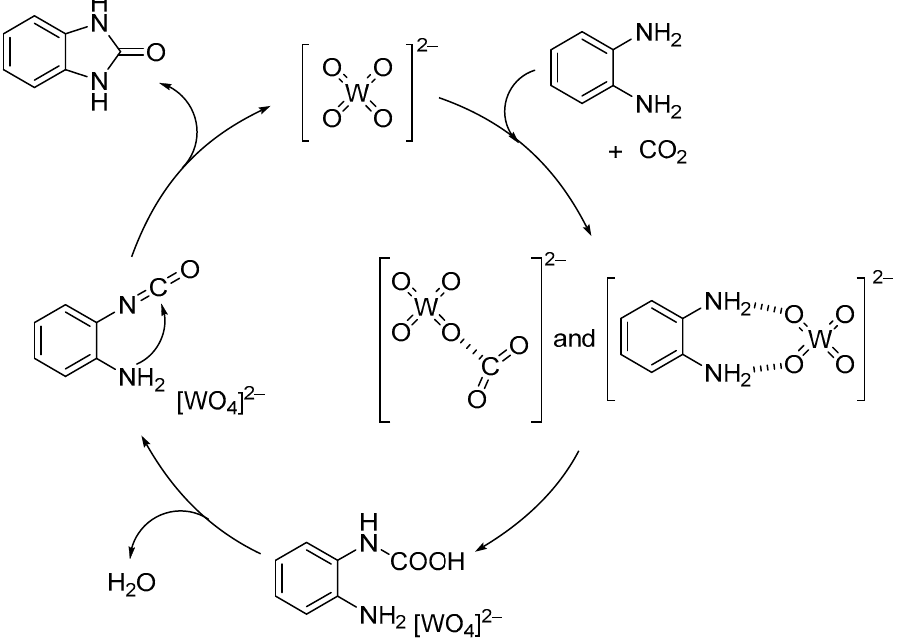
Figure 10. Proposed mechanism for the chemical fixation of CO 2 with aryldiamines catalyzed by TBA 2 [WO 4 ] [38].